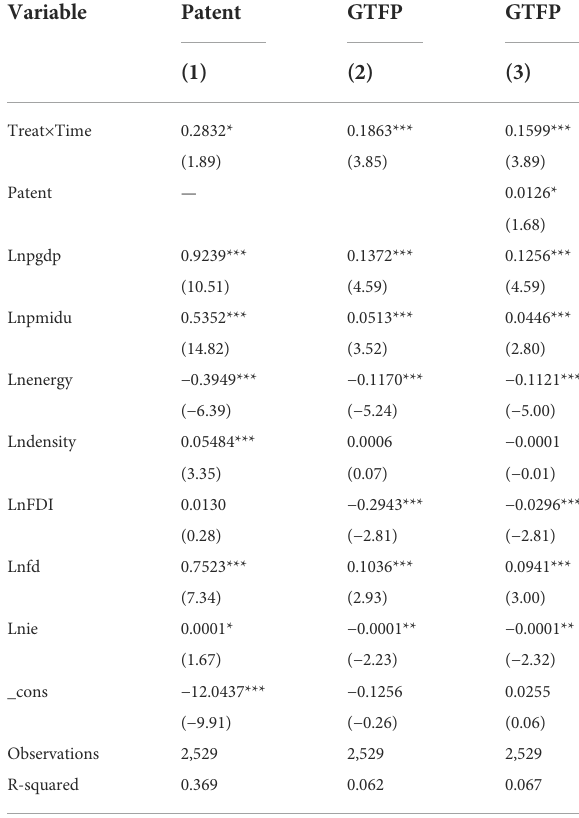
(Table 4), the incentive effect ( α 1 ) of the pilot policy on innovation compensation is signi fi cantly positive at the level of 1%, which is consistent with the conclusions of Cui et al. (2018). After the innovation compensation effect and pilot variables are all included in the regression (model 5), the